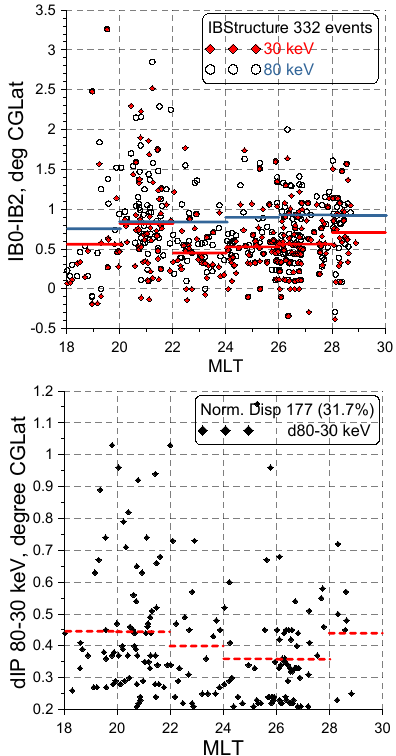
Figure 8. AE activity dependence of different IB dispersion types (a) and of LLPP occurrence.